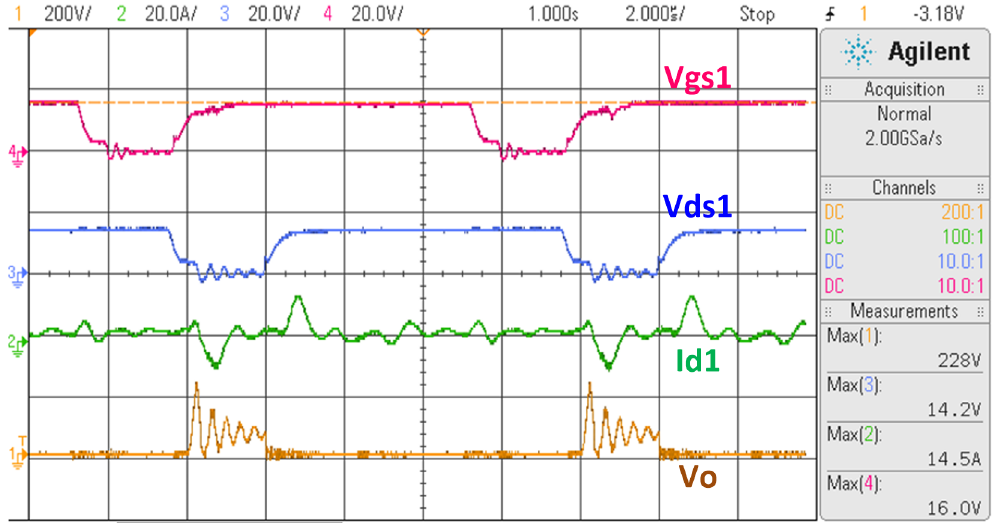
Figure 19. Switching characteristics: Violet—gate voltage, Blue—drain-source voltage, Green—drain current, Brown—output